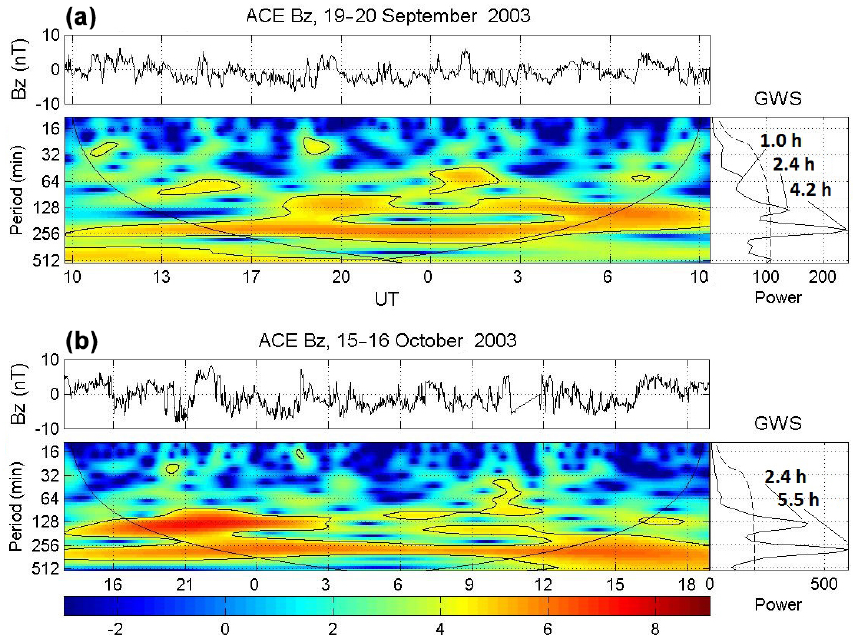
Figure 10. Wavelet spectra of the IMF B z component for the (a) 19–20 September 2003 tail crossing (T2) and for the (b) 15–16 October 2003 tail crossing (T5). The paraboloidal black line curve is the COI. Regions in the wavelet spectrum with confidence level at 95% are marked with black lines. Continuous wavelet spectrum background from red noise models shown in the GWS as a black dotted